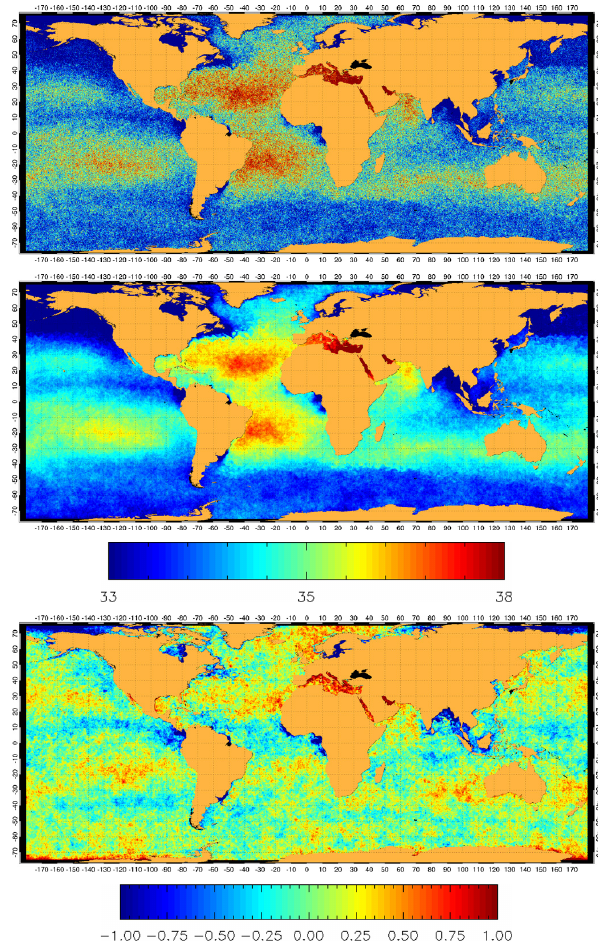
Fig. 9. Top: SSS after the introduction of correlated noise with input noise of standard deviation σ i = 1psu. Middle: SSS map after filter- ing the map on top using the SST map as a template. Bottom: Dif- ferences between the original (no noise) SSS map and the fused SSS